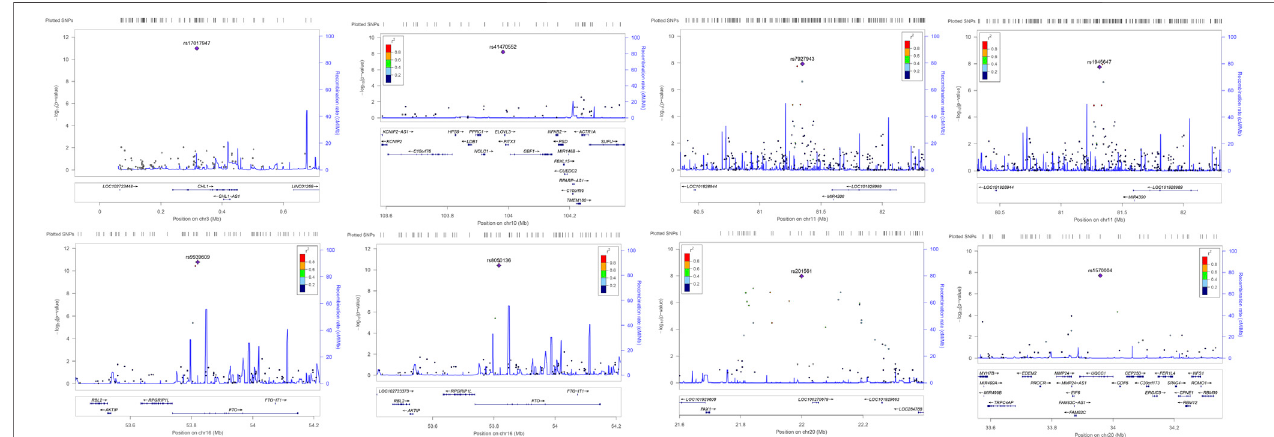
FIGURE3| Theregionalassociationplotsofthesigni fi cantSNPsidenti fi edinARIC.The p -valuesofrs17017947andrs41470552areevaluatedbyMANOVAmethod.The p -values of 7927943 and rs1945647 are estimated by TATES method. The p -values of rs9939609, rs8050136, and rs201561 are assessed by HCDCMANOVA method. The p -valuesofrs1570004isevaluatedbyHCDCTATES.LDisconstructedusingthehg19versionofthe1000Genome(American).Theplotswherers7927943andrs1945647are located show the 1,000-kb range around these most signi fi cant SNPs. The plots where the rest SNPs (rs7927943, rs1945647, rs9939609, rs8050136, rs201561,